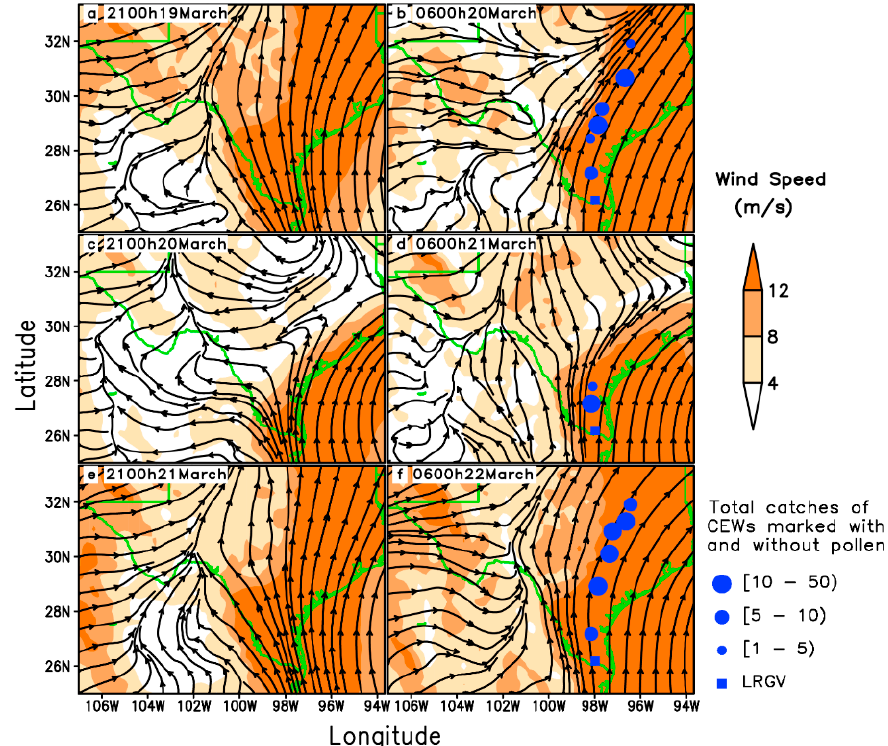
Figure 2. Wind fields at 950 hPa from 21:00 h to 06:00 h the next morning (local time) and pheromone trap catches of H. zea (CEWs) in Texas on 19–21 March 1995. Streamlines present wind fields; solid circles indicate locations where citrus pollen-marked CEW was captured.